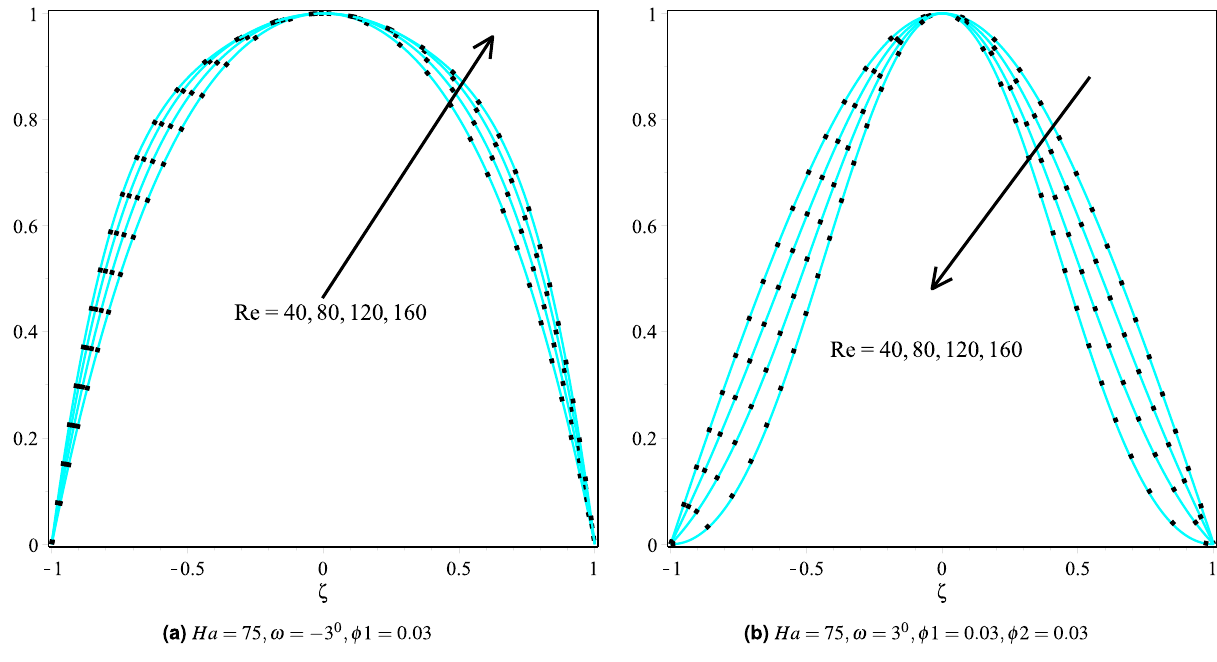
Figure 5. Velocity distribution of the fluid in converging and diverging channel with different Reynolds number for Copper-H 2 O and Cu-Al 2 O 3 /H 2 O, respectively.